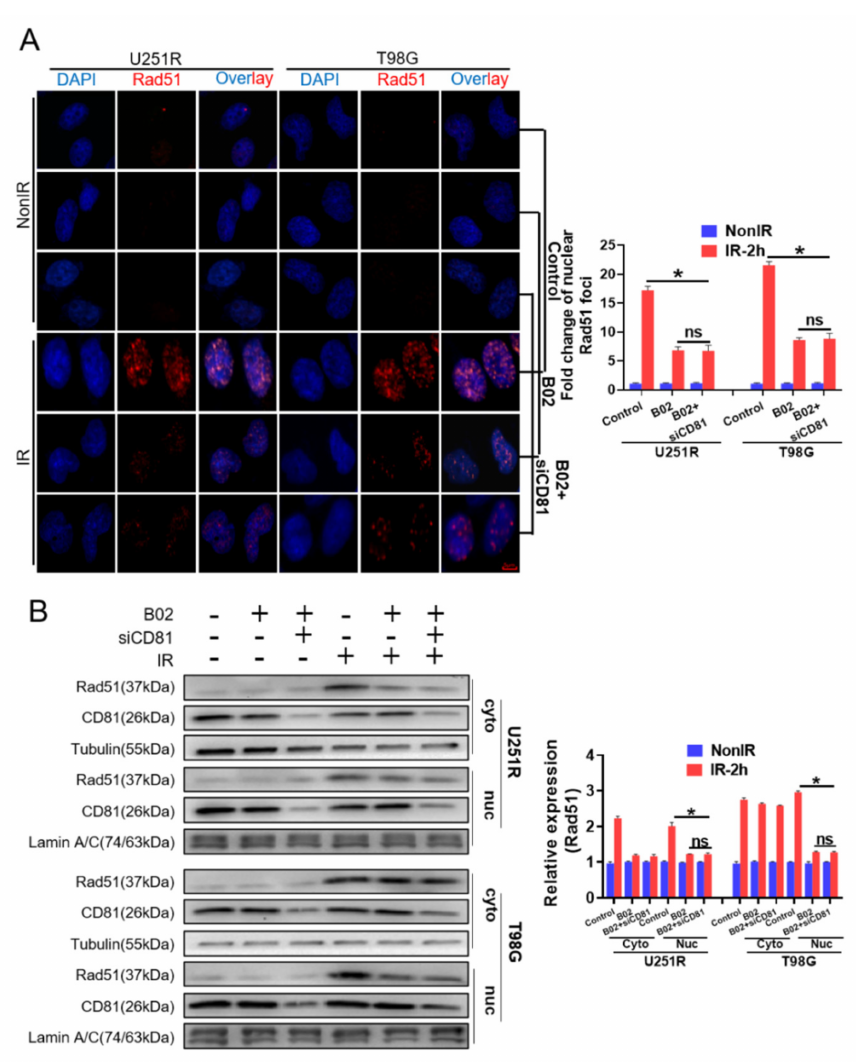
Figure 5. Effect of B02 treatment on Rad51 expression. U251R and T98G Cells were treated with B02 (10 µ M), its control (1‰ DMSO), or B02 + siCD81 and then irradiated with X-rays. ( A ) Representative immunostaining images ( left ) and quantification ( right ) of nuclear Rad51 foci in the cells at 2 h after 6 Gy irradiation. Blue, DAPI stained nuclear. Red, Rad51 foci. ( B ) Western blot assay ( left ) and quantitation ( right ) of cytoplasmic (cyto) and nuclear (nuc) proteins of Rad51 level and CD81 at 2 h after 6 Gy irradiation. *, p < 0.05 between indicated groups. ns, no significant difference ( p > 0.05 between indicated